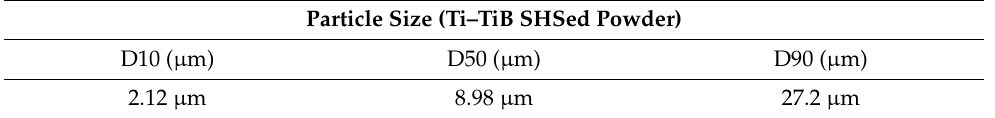
Table 1. Size distributions of the SHSed Ti–TiB